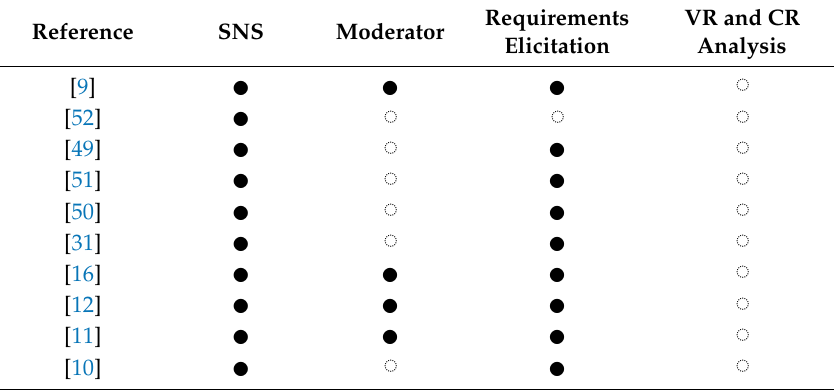
Table 13. Summary of related work that considers aspects related to our research.